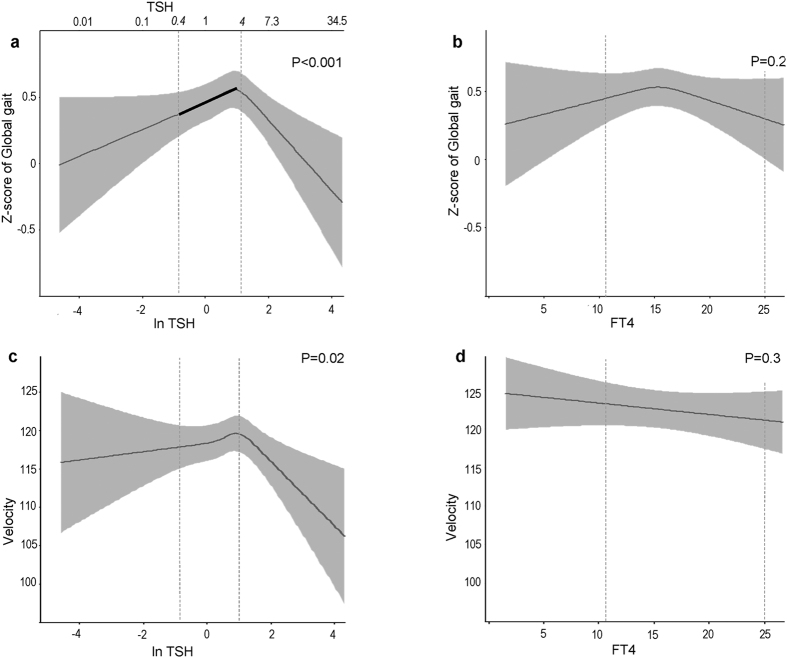
Association of thyroid function with Global gait and velocity.Adjusted for age, sex, cohort, smoking, alcohol intake, education level, height, weight, time interval between thyroid function measurement and gait assessment, knee pain or stiffness, hip pain or stiffness, prevalent stroke, CESD depression score, cerebellar cortical volume, intracranial volume, thyroid peroxidase antibodies. We utilized linear regression models with restricted cubic splines. TSH/FT4 concentrations are plotted against predicted means of Z-score Global gait and velocity (black lines) with 95% CI (gray areas). Dashed lines indicate the limits of TSH or FT4 reference ranges. A higher value of Global gait represents better gait.